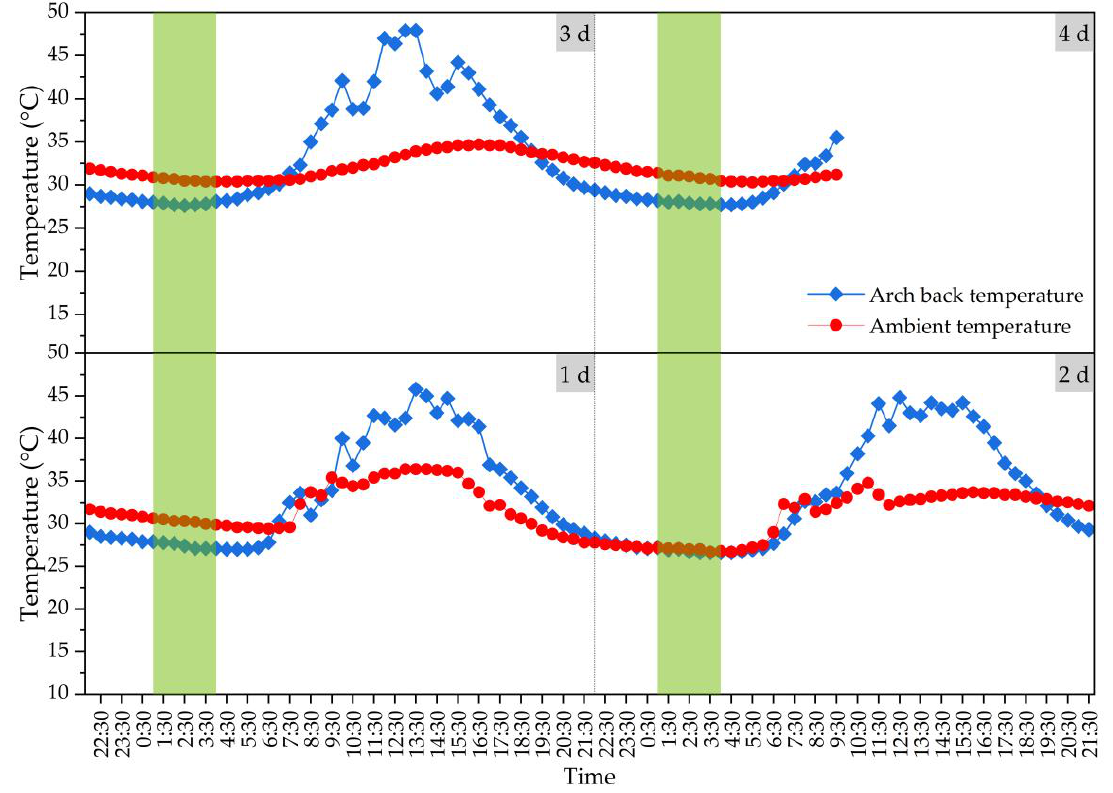
Figure 15. Arch back temperature at final closure and ambient temperature for 84 h (from 1 d to 4 d) before arch rib closure. (note: the green part is the appropriate closure time.)